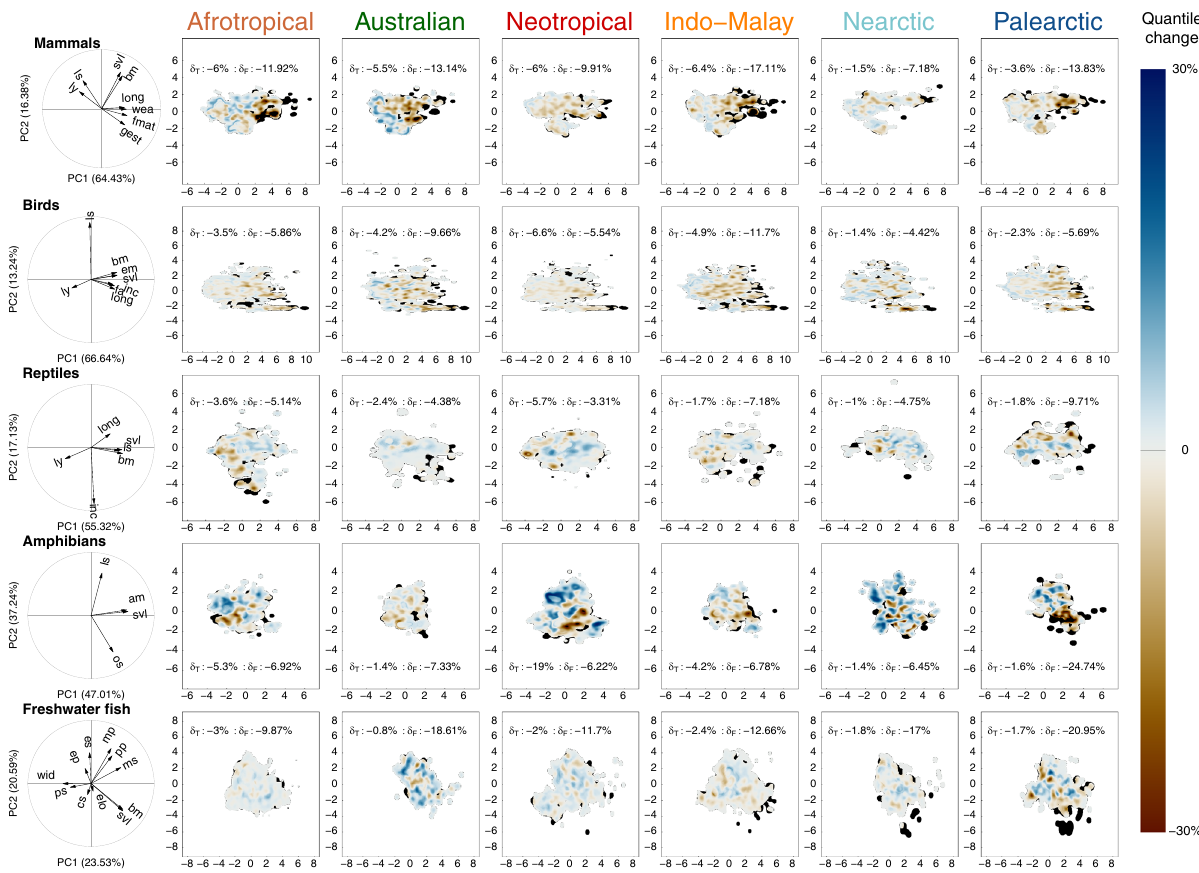
Fig. 5 Shifts in the functional diversity after the simulated extinction of threatened species for the taxonomic groups. For each group, the shifts in functional diversity are shown for the six biogeographic realms following the -NT extinction scenario (i.e. species considered as CR, EN, VU and NT were removed). Differences (expressed in quantiles changes) are calculated between the functional spectra of species assessed by the IUCN Red List before and after removing species classi fi ed as threatened (see de fi nition in the ‘ Methods ’ ). Brown tones re fl ect the threatened functional space after projected extinctions (i.e. areas representing trait values becoming relatively less frequent at the realm scale), and blue tones re fl ect the favourable functional space after extinctions (i.e. areas representing trait values becoming relatively more frequent at the realm scale). Black areas represent the lost functional space after extinctions. For each panel, the proportion of species ( δ T) and the proportion of total functional space ( δ F) that would be lost after extinction (expressed as a percentage of the current taxonomic and functional richness, respectively) is indicated. The functional shifts for all scenarios are in Supplementary Fig. 6 and associated values of functional diversity losses are in Supplementary Data 2. The correlation circles show the loadings of the considered traits in the resulting PCA for each group. De fi nitions of the trait abbreviations are in Table 1. Source data are provided as a Source data fi